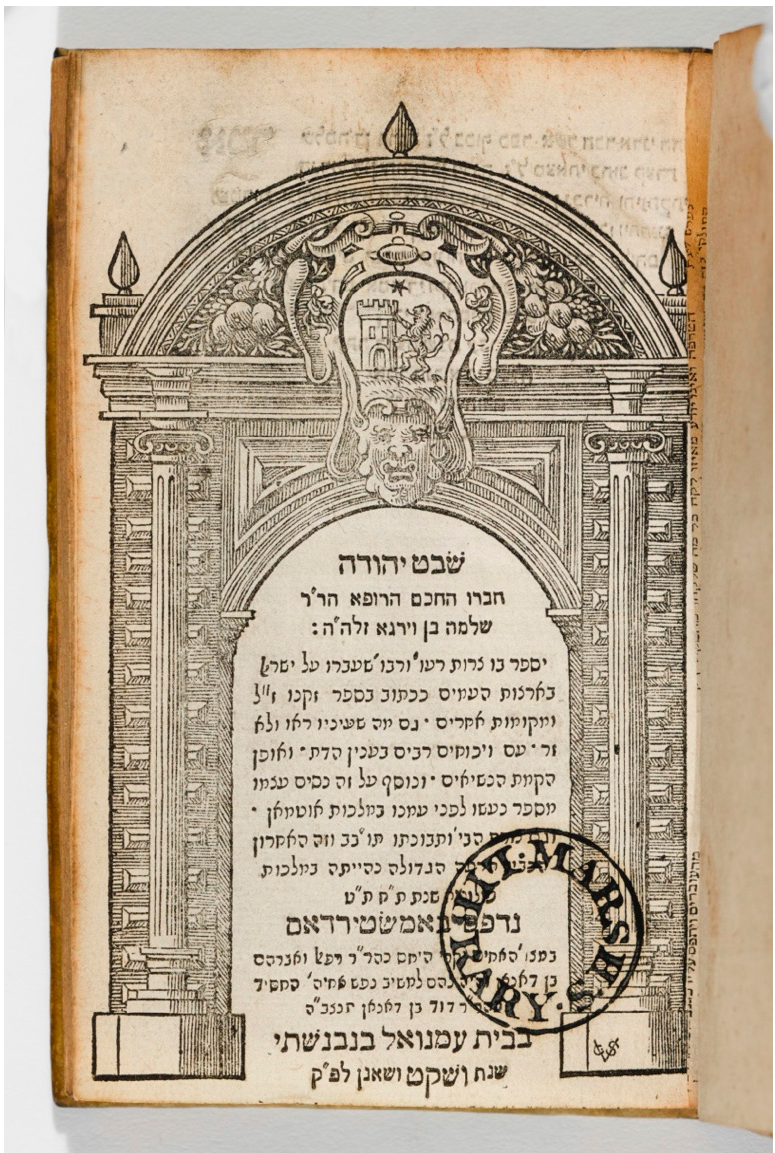
Figure 35. Shevet Yehudah (Sceptre of the Jews); Marsh’s Library B.3.5.11.